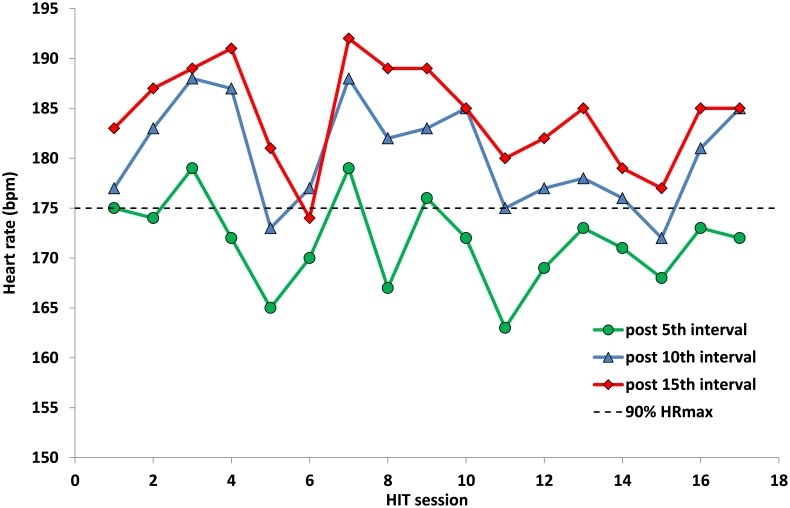
Peak heart rate values after the 5th, 10th, and 15th interval across the 17 HIT sessions during the 8-week training period.